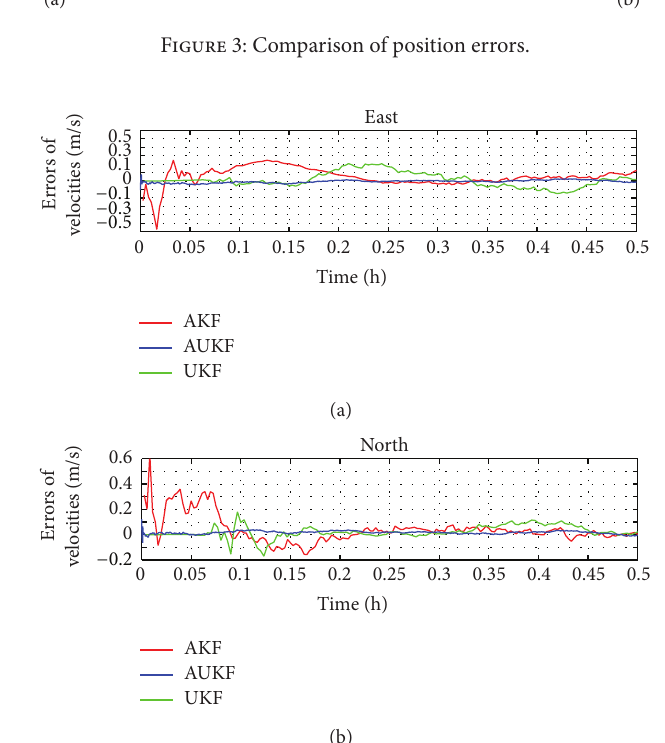
Figure 3: Comparison of position errors.